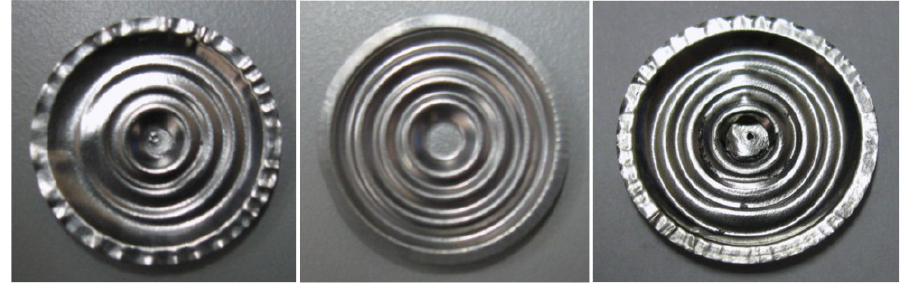
Figure 28. Appearance of semi die formed samples using 12 J (L), 15 J (M) and 18 J (R)